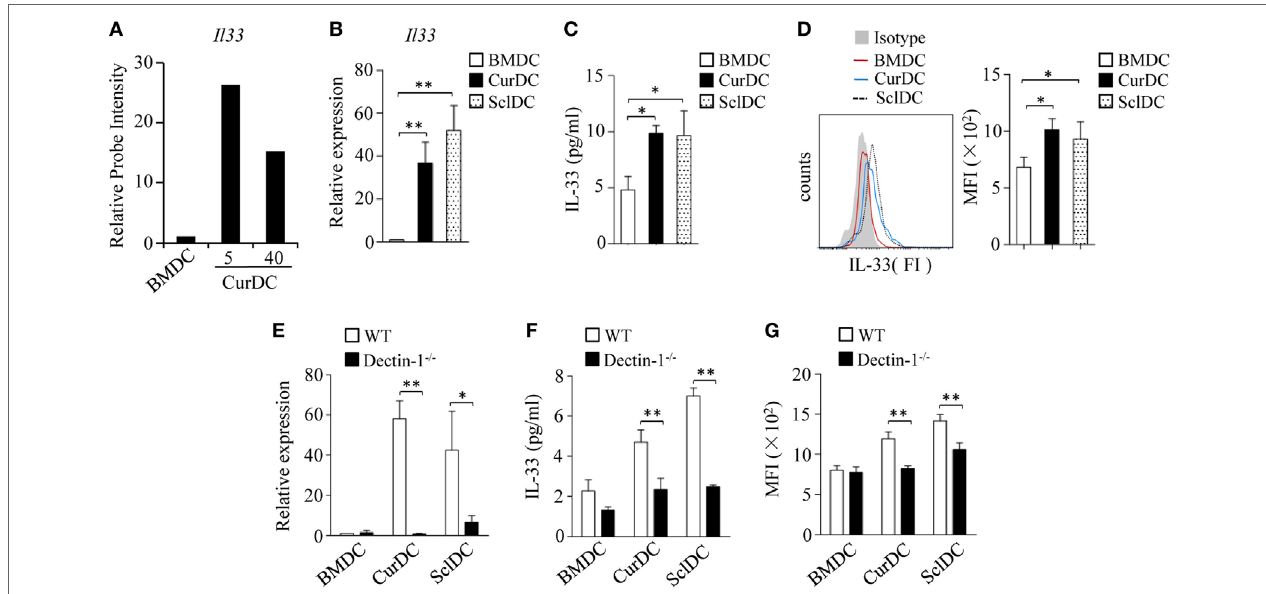
FigUre 1 | Dectin-1 signaling stimulates interleukin (IL)-33 expression in dendritic cells (DCs). (a) Relative abundance of Il33 mRNA levels in DCs extracted from microarray gene expression data. Mouse DCs matured by TNF- α /IL-1 β (BMDC), or Curdlan (CurDC) at doses of 5 and 40 µg/mL for 48 h were analyzed by microarrays. The probe intensity of Il33 in BMDCs was set at 1. (B–D) Mouse immature DCs were matured by TNF- α /IL-1 β , Curdlan, or Scleroglucan (SclDC) for 48 h. (B) Quantitative polymerase chain reaction (qPCR) analyzed the mRNA levels of Il33 in DCs. The experiments were performed three times ( n = 3). (c) Enzyme-linked immunosorbent assay (ELISA) assessed IL-33 secretion by DCs. The experiments were performed three times ( n = 3). (D) Intracellular staining of IL-33 in DCs. Right, summarized results of three independent experiments obtained as the left. MFI, mean fluorescence intensity. The experiments were performed three times ( n = 3). (e–g) BMDCs, CurDCs, and SclDCs were generated from wild-type (WT) or dectin-1 − / − mice. Same as in (B–D) , the mRNA (e) and protein (F,g) levels of IL-33 expressed by DCs were analyzed by qPCR, ELISA, and intracellular staining separately. The experiments were performed three times ( n = 3). Results shown are the mean ± SD of three (B–g) independent experiments. * P < 0.05; ** P < 0.01